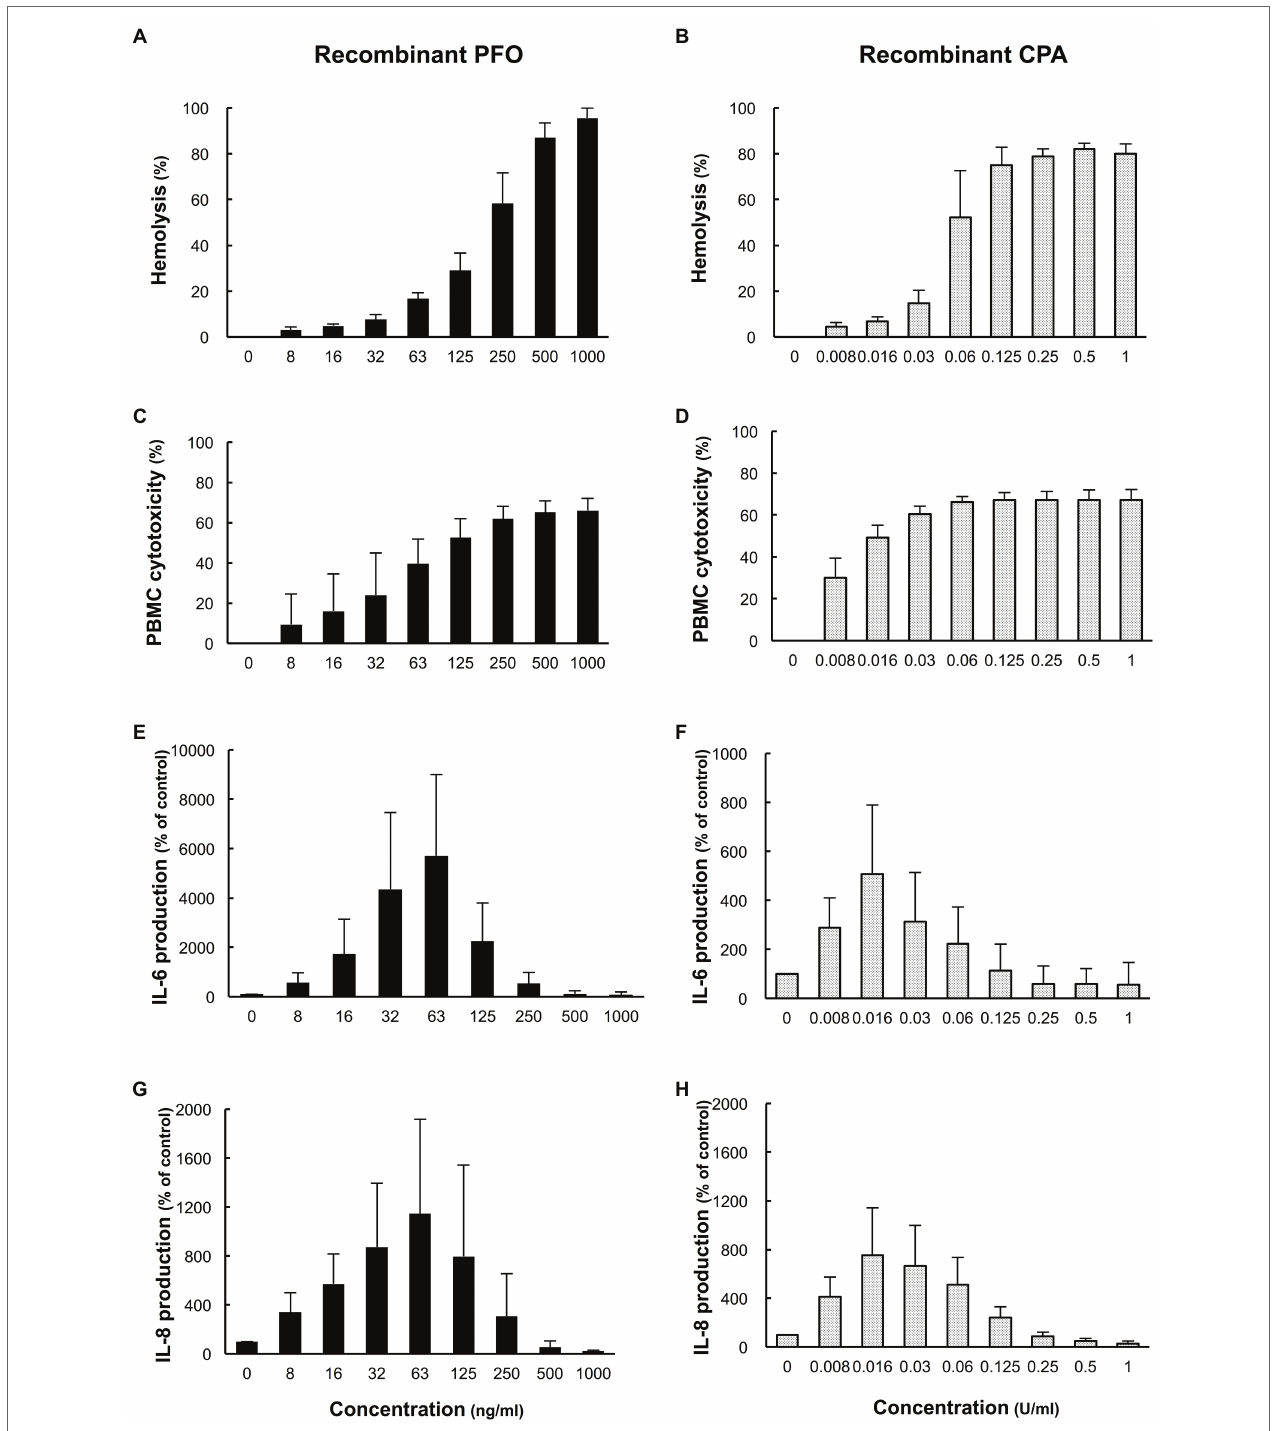
FIGURE 5 | Effects of recombinant PFO (rPFO) and recombinant CPA (rCPA) on human blood cells. The effects of rPFO and rCPA were measured using human blood cells collected from five healthy volunteers on the day of the experiment. (A) Hemolytic effect of rPFO on a 40% human erythrocyte suspension. (B) Hemolytic effect of rCPA on a 40% human erythrocyte suspension. (C) Cytotoxicity of rPFO in human PBMCs. (D) Cytotoxicity of rCPA in human PBMCs. (E) IL-6 production by human PBMCs induced by rPFO. (F) IL-6 production by human PBMCs induced by rCPA. (G) IL-8 production by human PBMCs induced by rPFO. (H) IL-8 production by human PBMCs induced by rCPA. The values are the average of five independent experiments conducted with technical duplicates, and the error bars indicate the